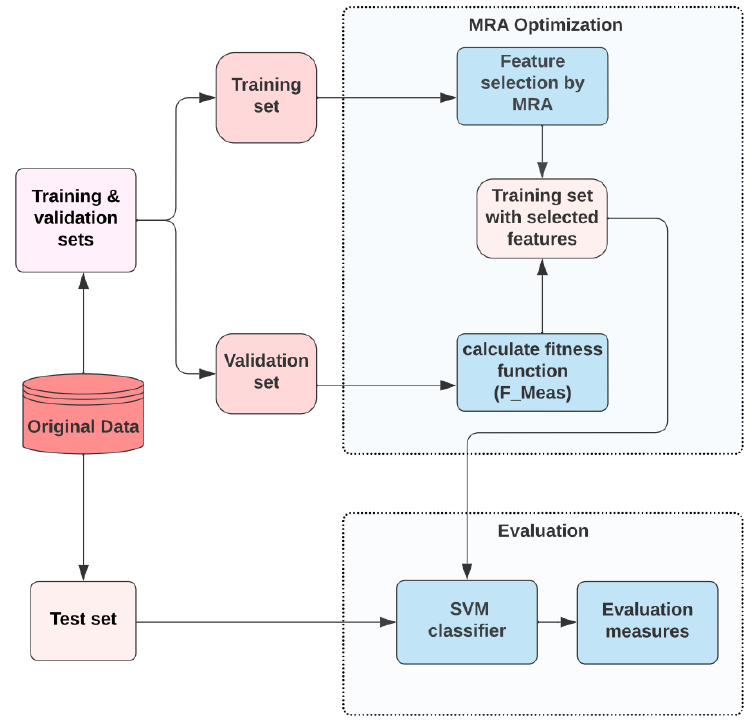
Figure 1. Flow diagram of MRA for feature selection method in classification.